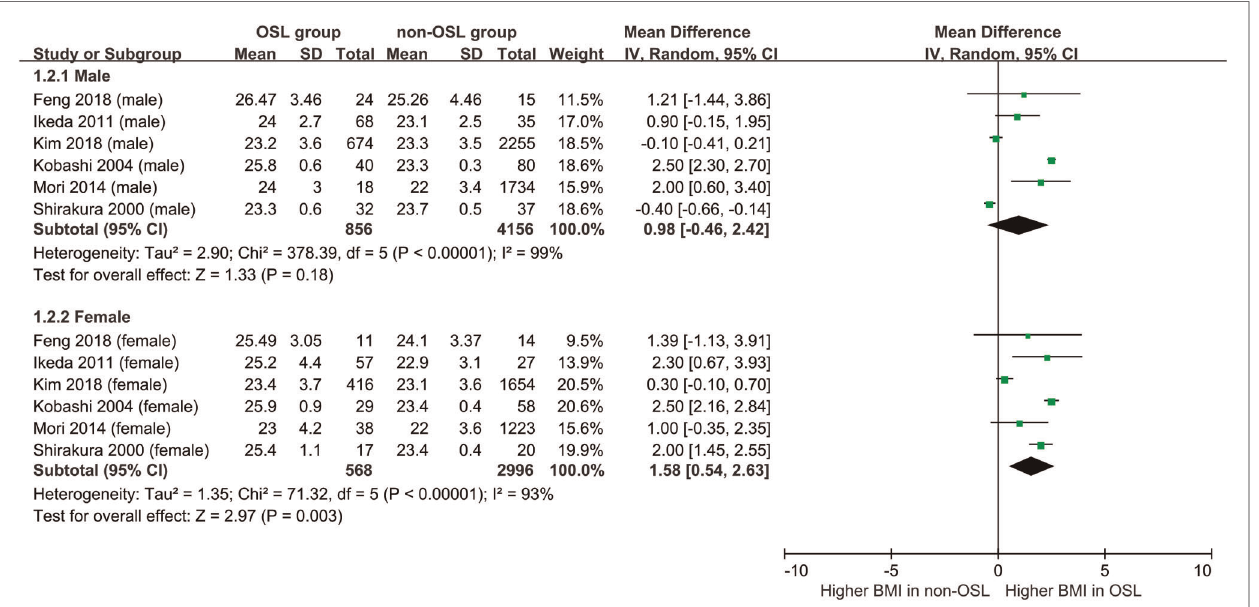
FIGURE 3 | Subgroup analysis strati fi ed by the gender for the relationship of BMI with the onset of OSL ( top , males; bottom ,